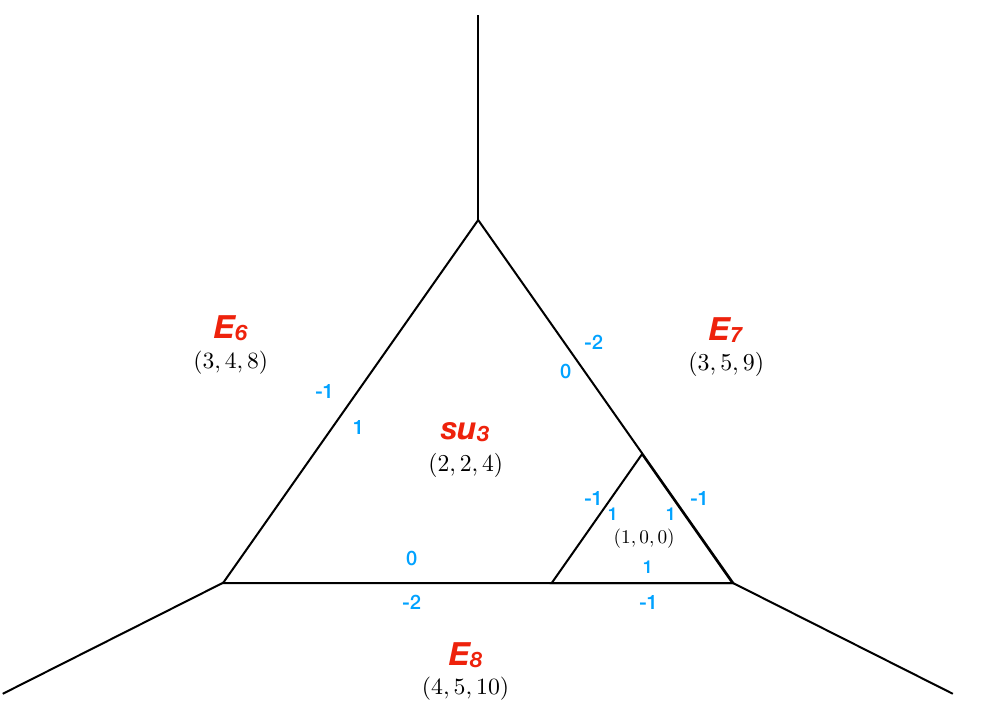
Figure 9 . The blowup of the minimal E 6 (cid:0) E 7 (cid:0) E 8 Yukawa